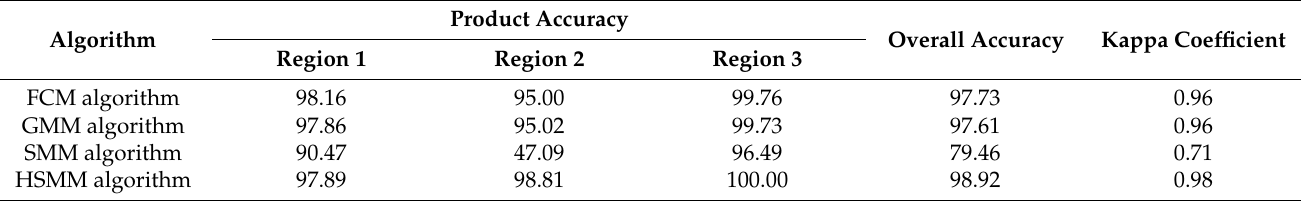
Table 2. The segmentation accuracy of the simulated image.